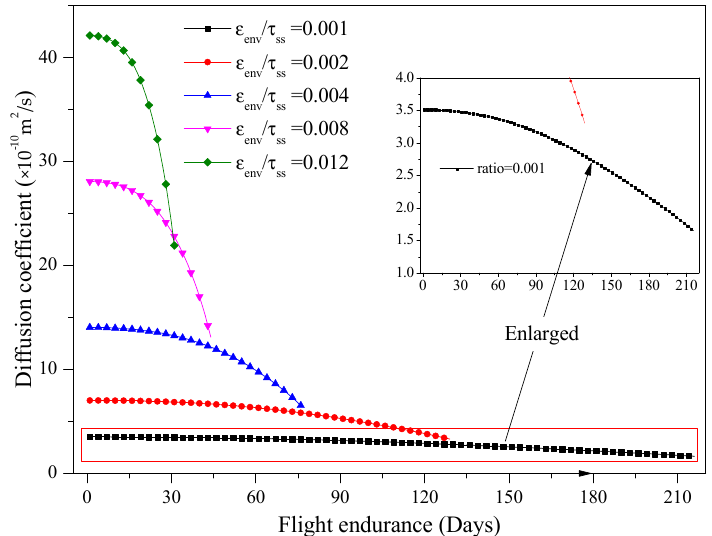
ε τ / Figure 10. Effects of ε env / τ ss on the diffusion coefficient of the Figure 10. Effects of on the diffusion coefficient of the envelope. env ss τ / env